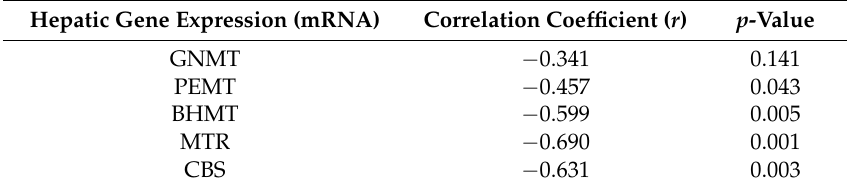
Table 2. Correlation between serum GPT level and hepatic expressions of genes related to one-carbon metabolism. Hepatic Gene Expression (mRNA)